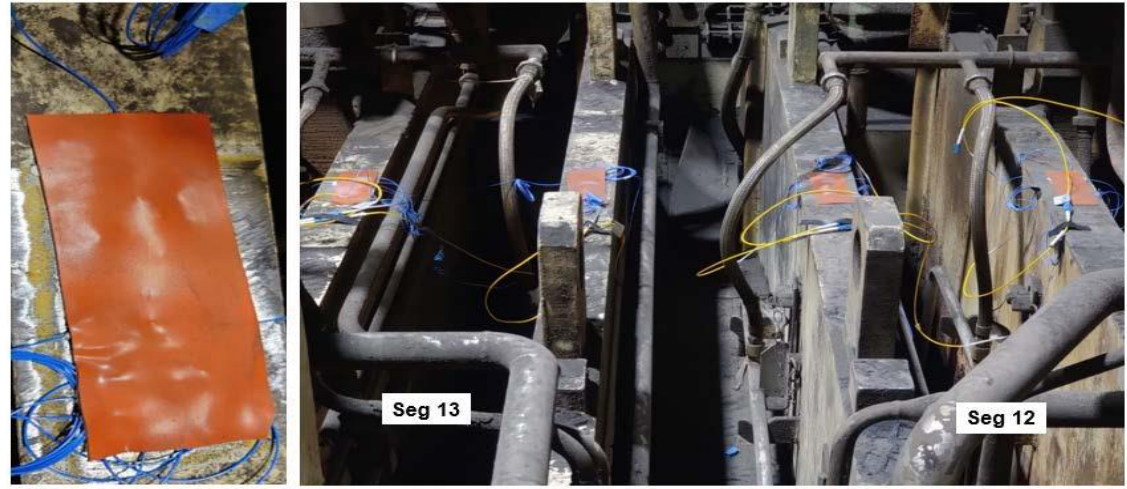
Figure 7. Final sensor installation with a rubberized protective covering.